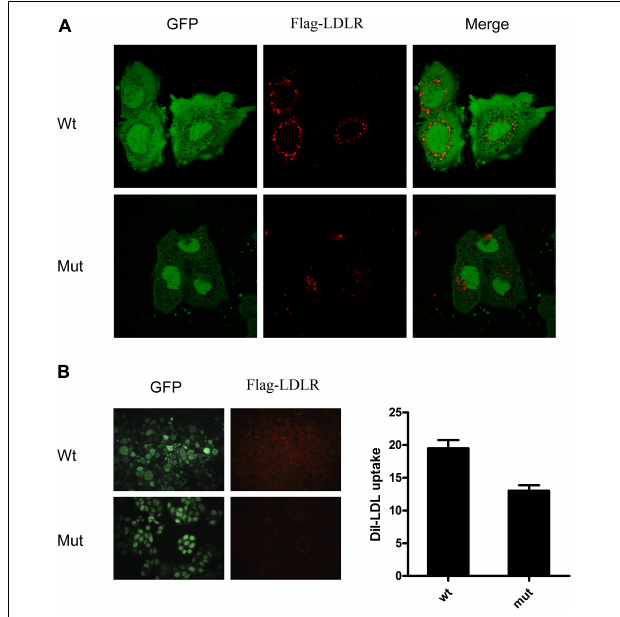
FIGURE 4 | DiI-LDL uptake measurement showed that internalization capacity of HepG2 cells with mutant LDLR with exon 16 deletion was substantially lower than that observed in cells with WT LDLR. (A) Red fluorescence represents DiI-LDL, and green fluorescence represents HepG2-transfected cells. (B) Quantitative analysis showed that capacity of DiI-LDL uptake was significantly reduced in HepG2 cells transfected with c. G < A 2389 that resides in 16th exon of LDLR as compared with HepG2cells transfected with WT LDLR.